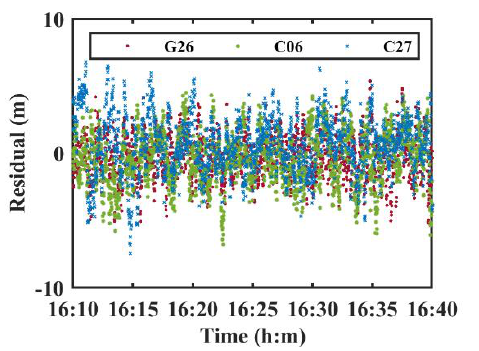
Figure 8. The time series of residual for Huawei.